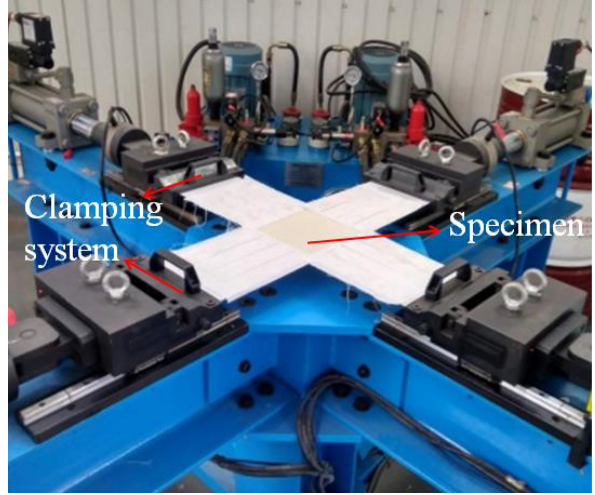
Figure 1. The envelope materials ( a ) macro morphology; ( b ) envelope layout.